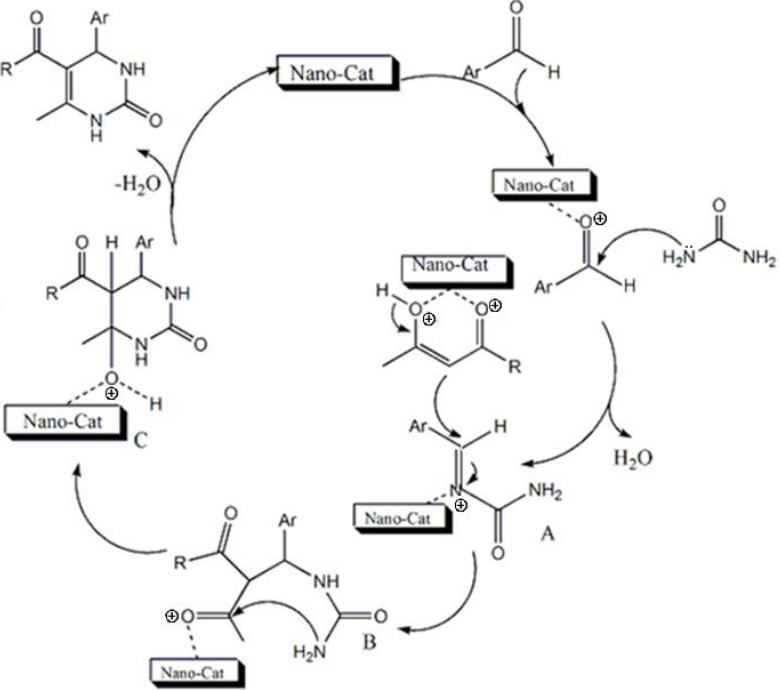
Figure 4. Proposed mechanism for one-pot synthesis of dihydropyrimidinones derivatives from aldehyde, ethyl acetoacetate, and urea using Cu@SBA-15.